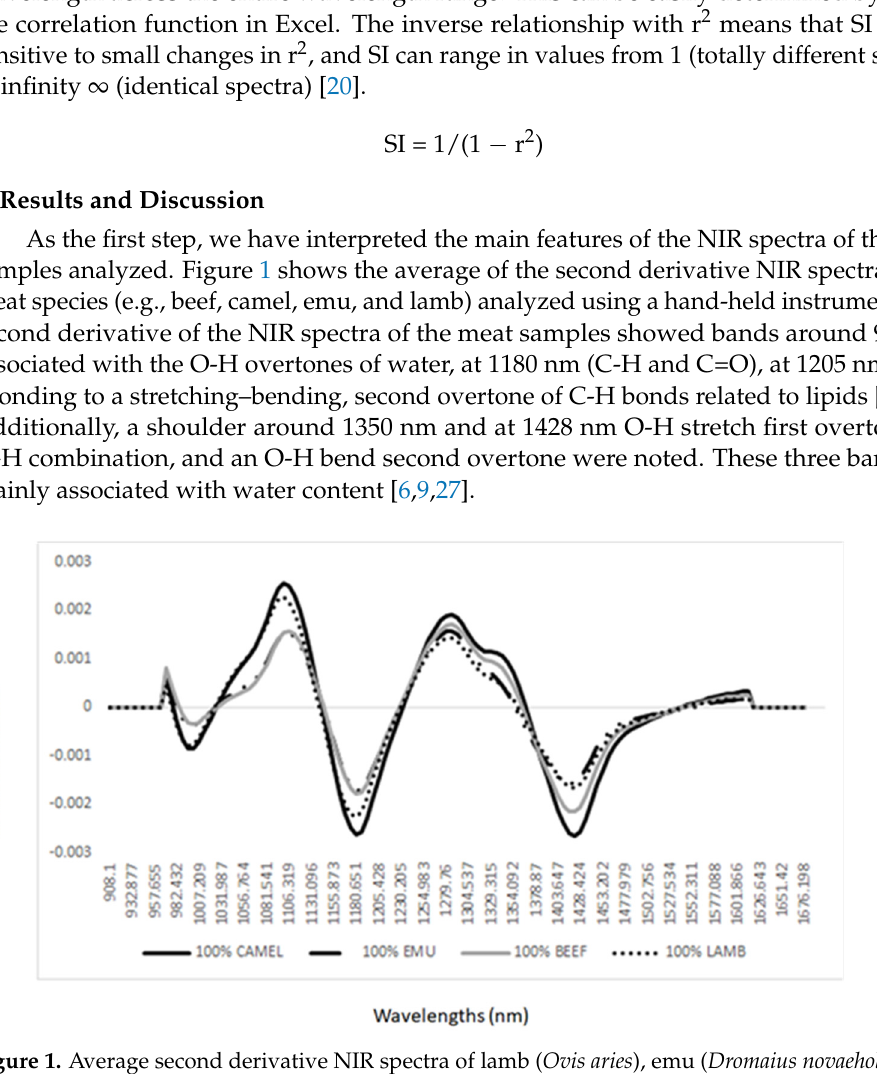
Figure 1. Average second derivative NIR spectra of lamb ( Ovis aries ), emu ( Dromaius novaehollandiae ), camel ( Camelus dromedarius ), and beef ( Bos taurus ) minced samples analyzed using a portable NIR in- strument.